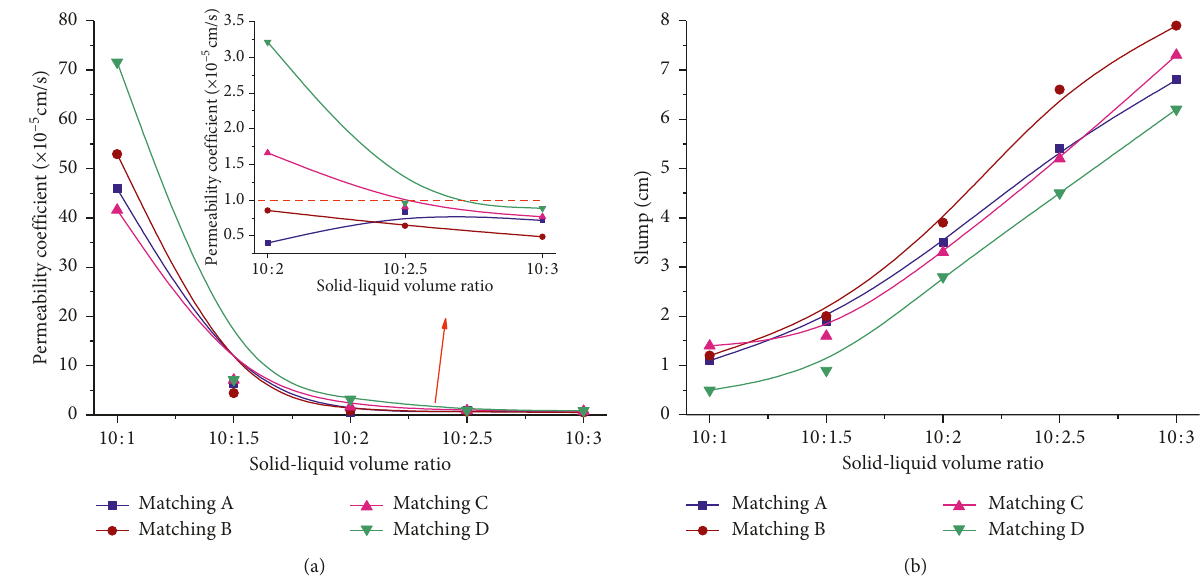
Figure 7: Improved variation in slag performance with the volume ratio. (a) Slag permeability coefficient. (b) Slag